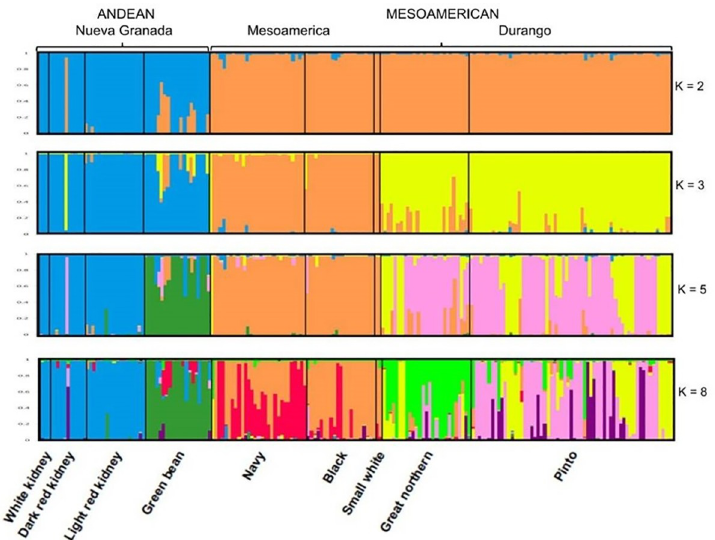
Fig 2. Population structure analysis for 192 advanced cultivars of Andean and Mesoamerican common bean races based on SSRs analysis. K-values of subpopulations are shown to right and naming of common bean commercial market class given below. Each individual is represented by a vertical line, and cluster assignments are indicated by color. Bar graphs were developed with the program DISTRUCT.